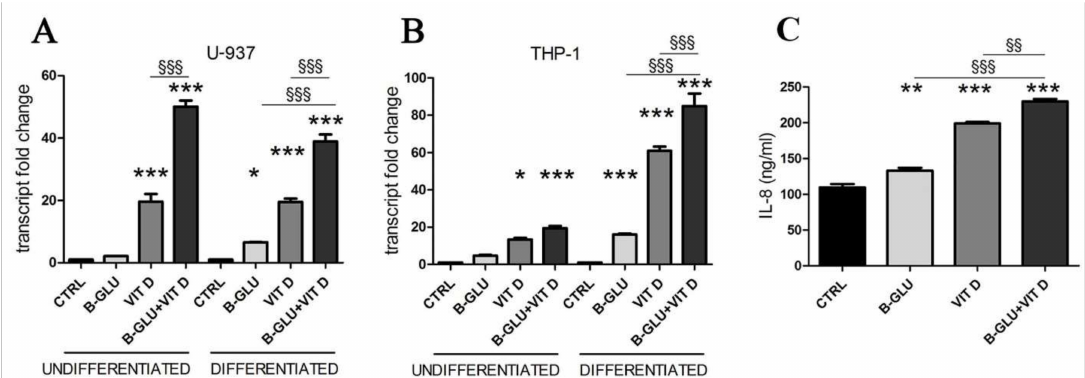
Figure 1. Vitamin D and beta-glucans stimulate IL-8 expression and secretion. Two cell lines were differentiated to macrophages by TPA treatment or used as undifferentiated monocytes. After 24 h of treatment with 100 µ g/mL beta- glucans (B-GLU) and 100 nM vitamin D (VIT D) the transcript levels of IL-8 were measured by real-time PCR. ( A ) U-937 cells; ( B ) THP-1 cells. ( C ) The levels of IL-8 were measured in the culture medium of differentiated U-937 cells. Results are means ± SEM. * P < 0.05, ** P < 0.01 and *** P < 0.001 vs. ctrl; § § P < 0.01 and § §§ P <